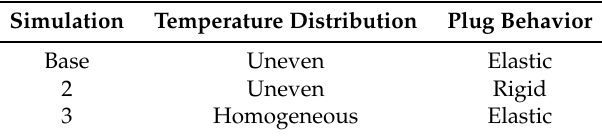
Table 7. Wall thickness eccentricity FE models.